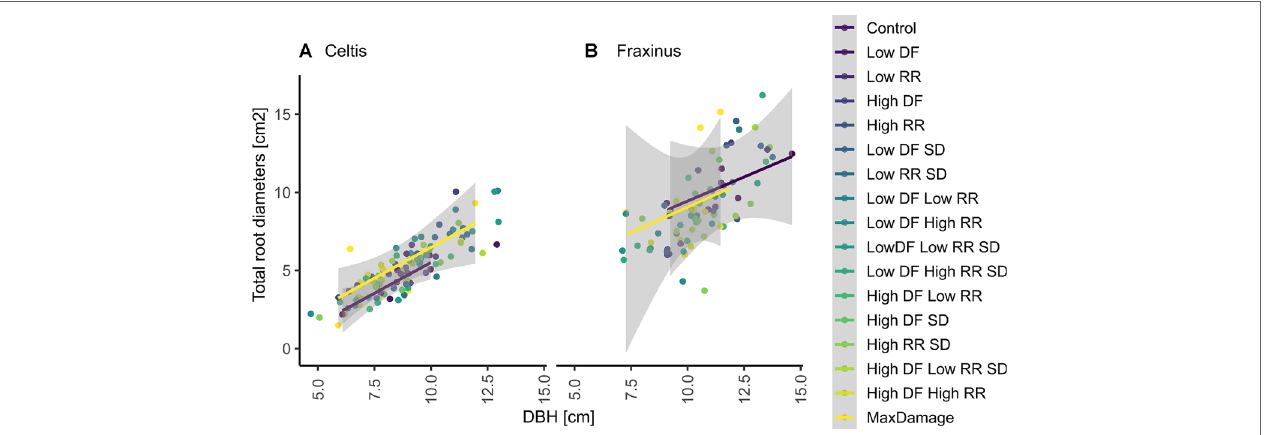
FIGURE 8 | Correlation between DBH and the sum of all larger root diameters at 20 cm from the stump center in 2017 on (A) Celtis and (B) Fraxinus . The fitted linear model shows a positive linear correlation with the control group (blue line) and with the maximum combination of damage treatment (yellow line) where r 2 = 0.7 for Celtis and r 2 = 0.5 for Fraxinus , respectively, for both treatments. None of the groups were significantly different for Fraxinus ( P > 0.5); similarly, all groups for Celtis were not significantly different, but the “low DF low RR,” which showed a significant reduction in root